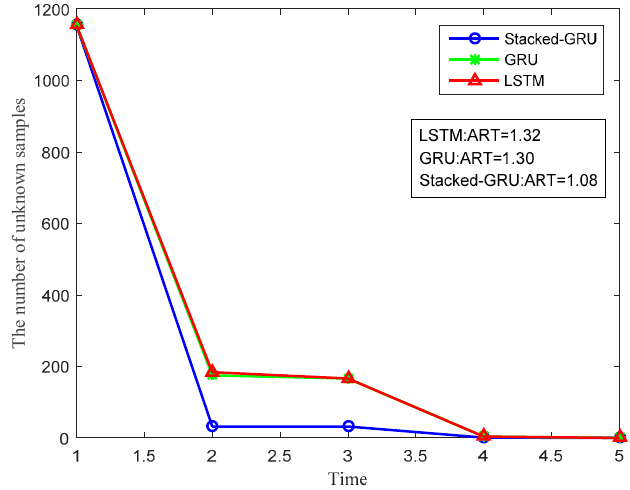
Figure 7 . Comparison of different model performance. Figure 7. Comparison of different model performance.